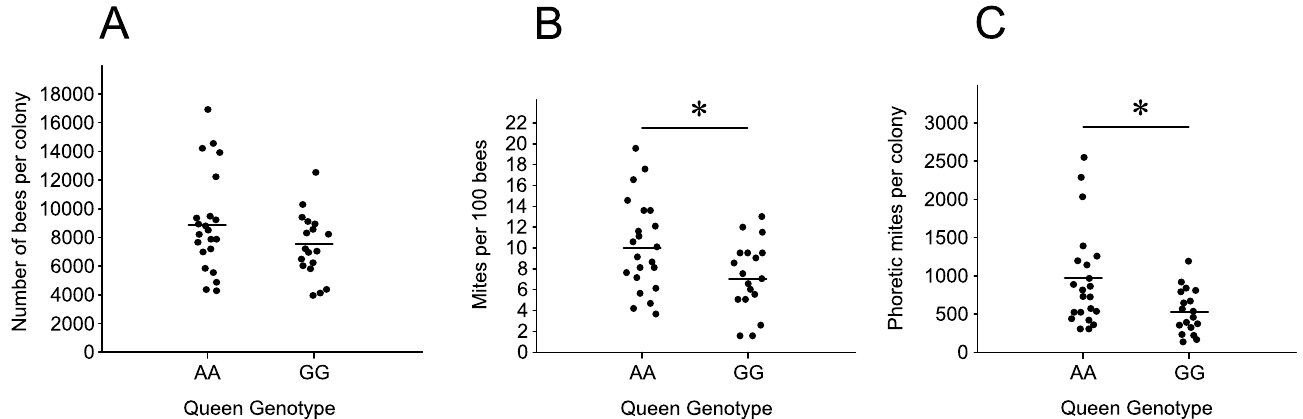
Fig 2. Colony size (A), mite wash (B) and estimated total phoretic mite infestation in colonies (C) headed by treatment (GG) and control (AA) queens at about 10 weeks of the beehive trial. The mean of each data set is represented by a horizontal bar. Asterisks indicate significance between genotypes ( � P < 0.05).